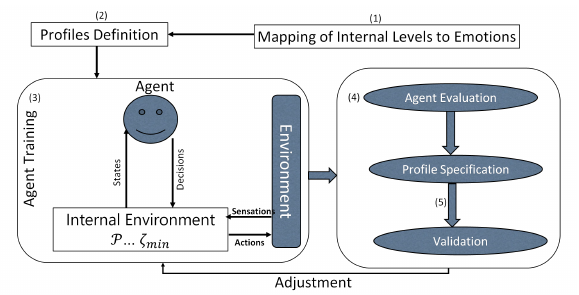
Figure 2. Stages to obtain the agents’ profiles in the explicit motivation model. The left block shows the architecture of the reinforcement learning agent with intrinsic motivation given by Singh et al.